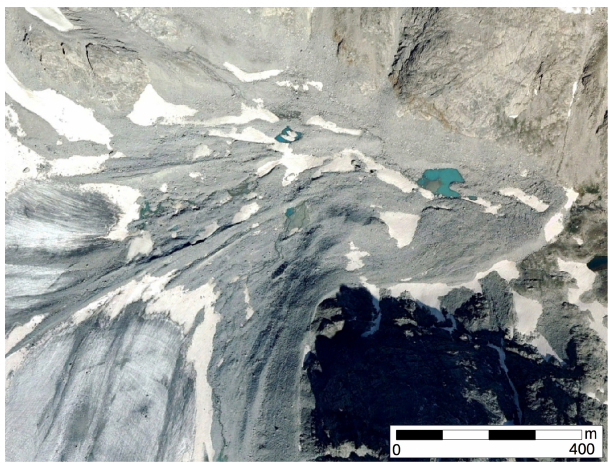
Figure 1. Example of a prototypical debris-covered glacier exhibit- ing expansive surfaces of exposed ice in the accumulation zone and obvious supraglacial lakes and streams on its surface. This ex- ample typifies the debris-covered glacier features we deliberately set out to exclude from this inventory. Image credit: © Google